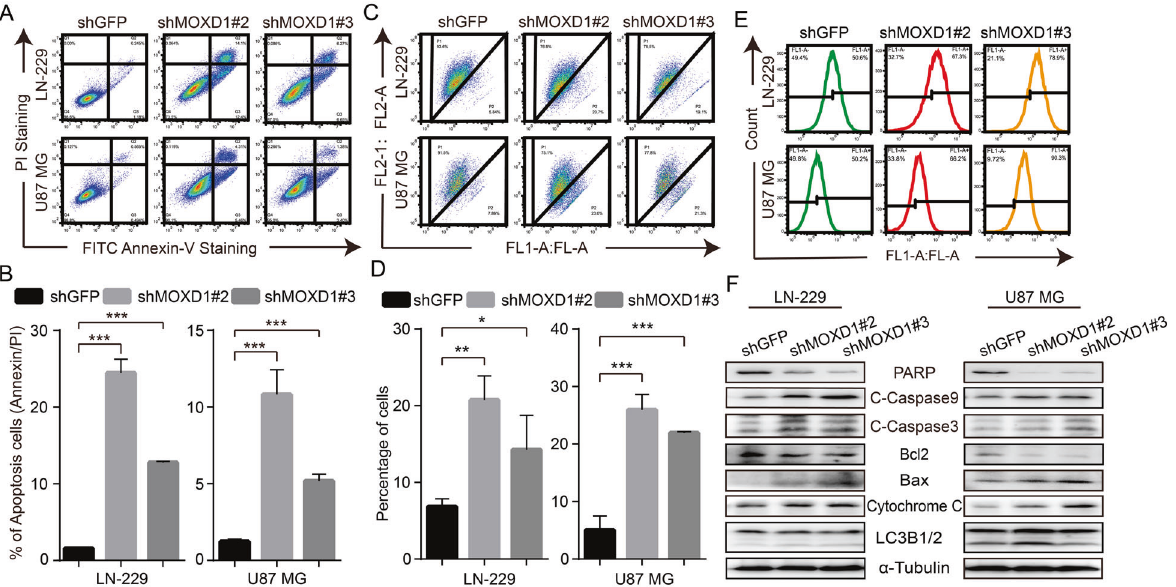
Fig. 5 Blocking MOXD1 induces cell apoptosis, mitochondrial membrane potential drop and ROS generation in GBM cells. A Apoptosis of MOXD1 knockdown cells was assessed by fl ow cytometry. B Statistics of apoptosis of MOXD1 knockdown cells. C mitochondrial membrane potential of MOXD1 knockdown cells was assessed by fl ow cytometry. D Statistics of mitochondrial membrane potential drop of MOXD1 knockdown cells. E ROS level MOXD1 knockdown cells was was assessed by fl ow cytometry. F Weatern blot assay was used to deterct mitochondrial apoptosis-related